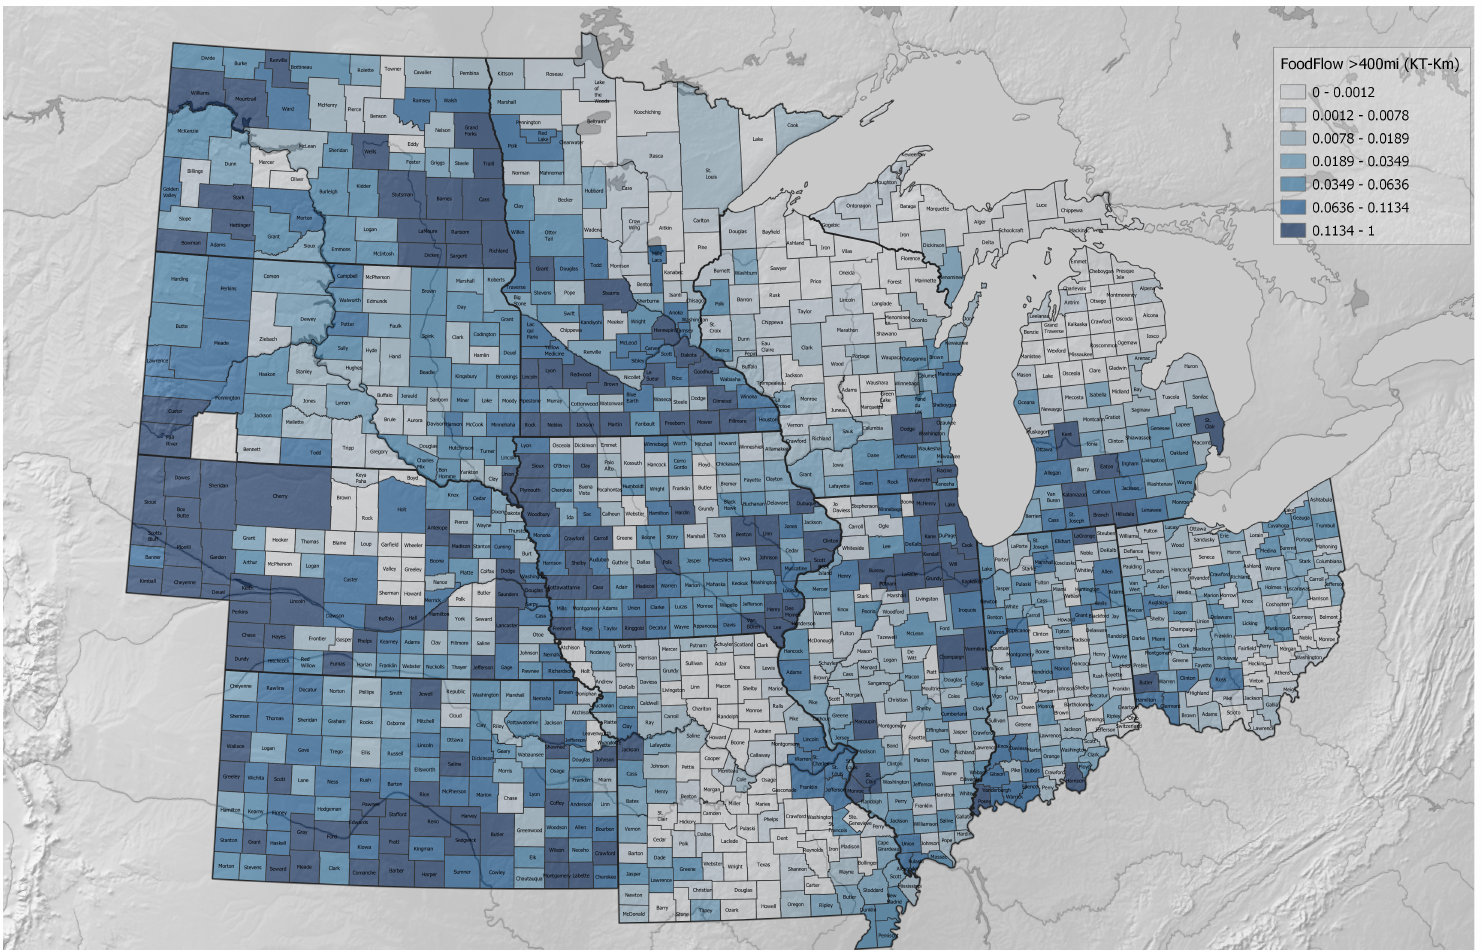
Figure A12. Product of food exports by weight times distance traveled, only including domestic flows over 400 miles (644 km), 2012. Values were all rescaled through dividing by the largest value present for any of the counties included here (3.670 × 10 6 kt-km from Richland County, North Dakota), as this transformation was applied to the variable data as they were placed into the index expression. Methods for Food_Flow_Over400mi_KTxKm are described in the article main text and Supplementary Materials. Data from [65] were